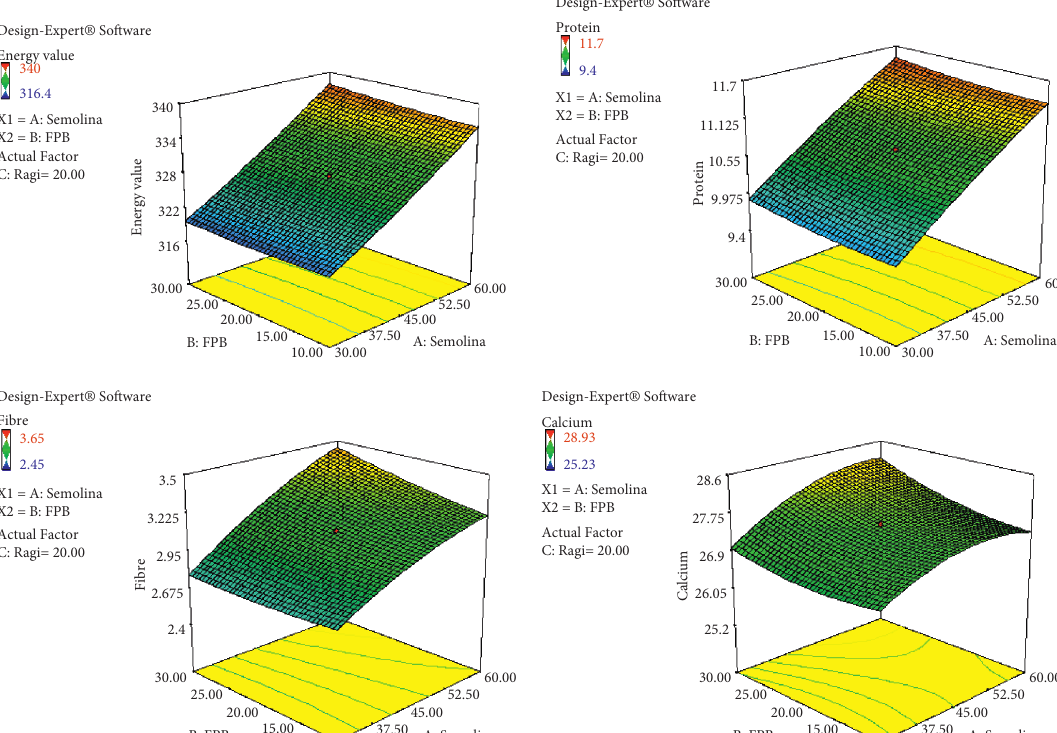
Figure 2: Three-dimensional (3D) surface plot indicating cumulative effects of the independent variables ( A � semolina, B � FPB, and C � finger millet) on the response variables, viz, nutritional parameters such as energy (a), protein (b), fibre (c), and calcium (d) of fruit peel macaroni.